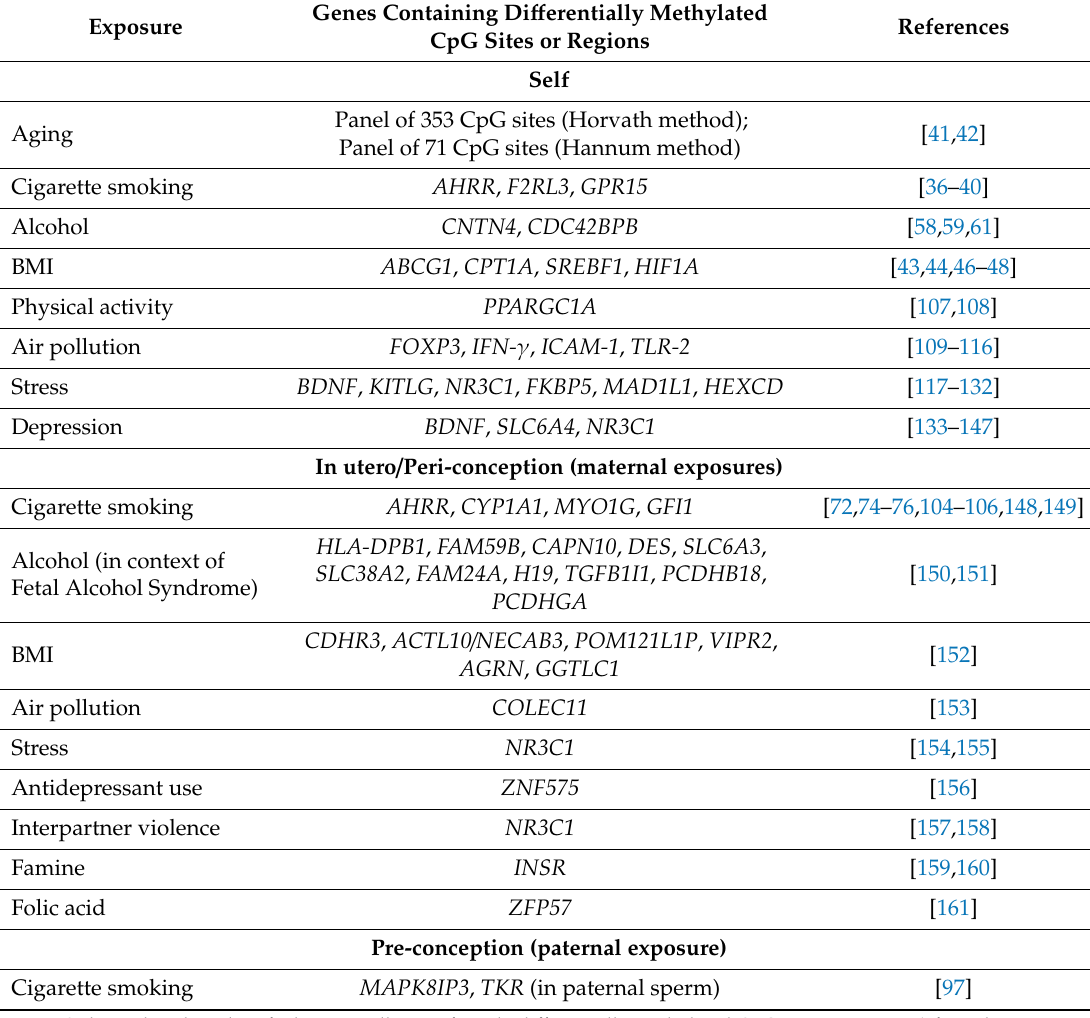
Table 1. Lifestyle or environmental exposures associated with di ff erential DNA methylation patterns in humans